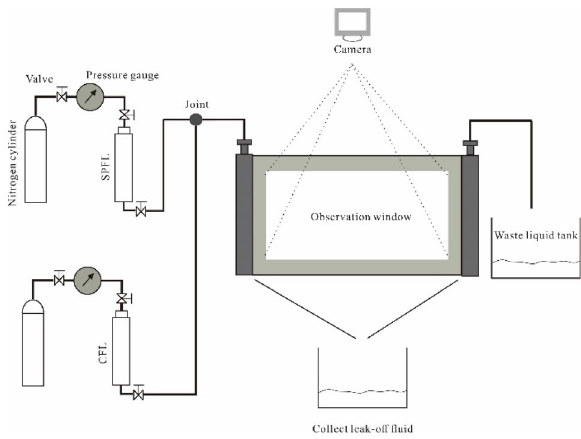
Fig. 2 Physical simulation device for the flow of the SPFL